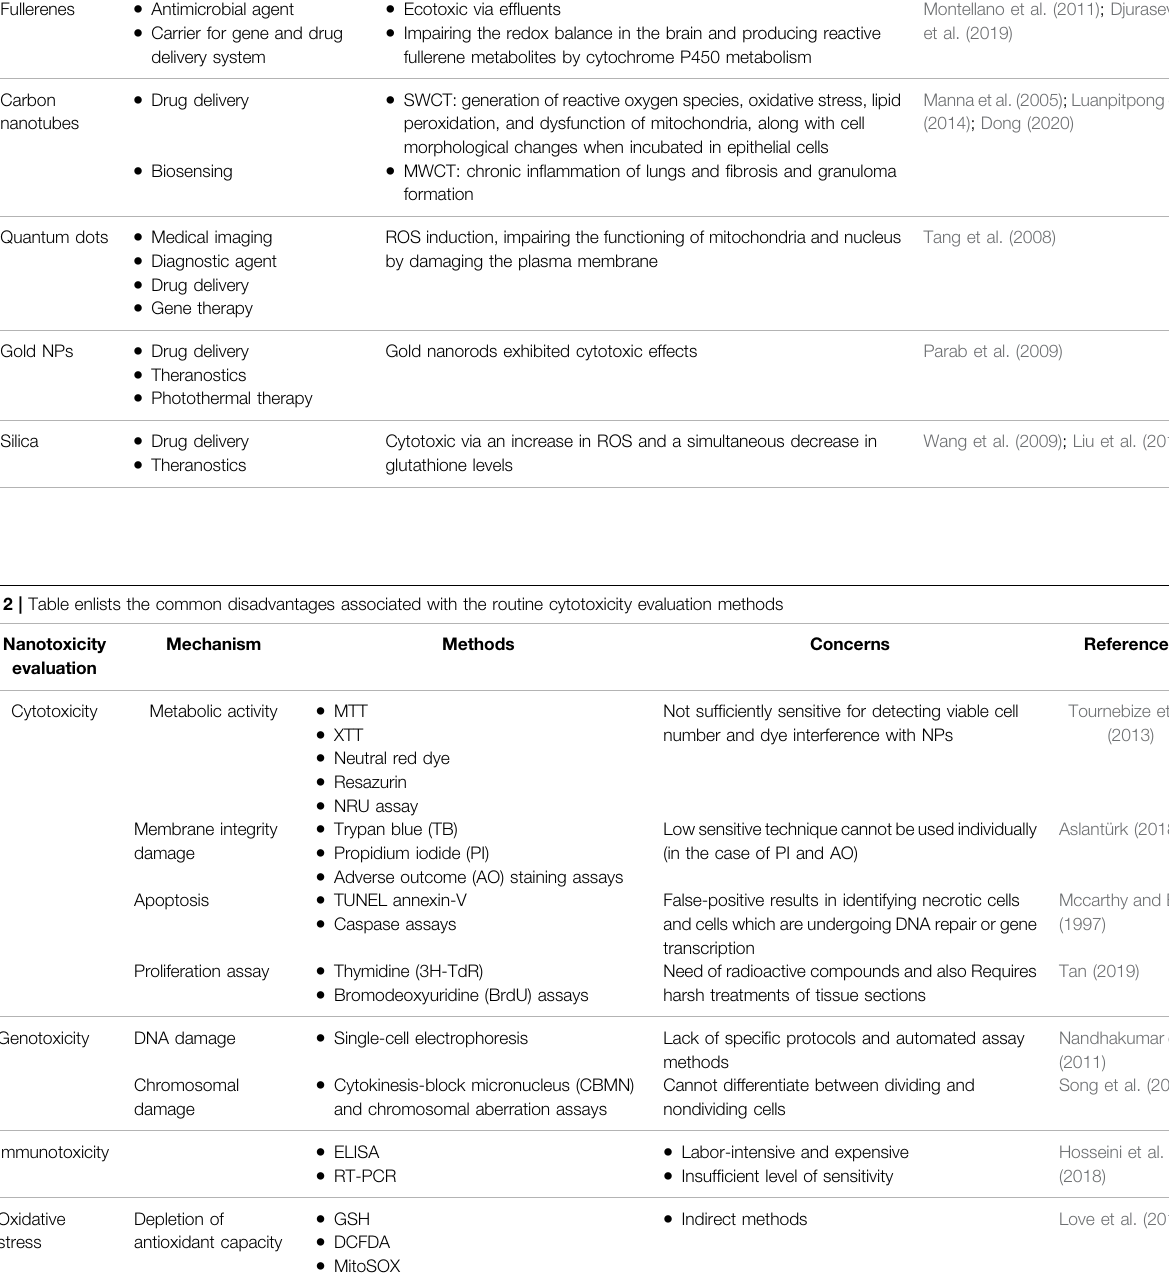
TABLE 1 | Nanotoxicological outcomes of some commonly employed NPs in nanomedicine S. no.